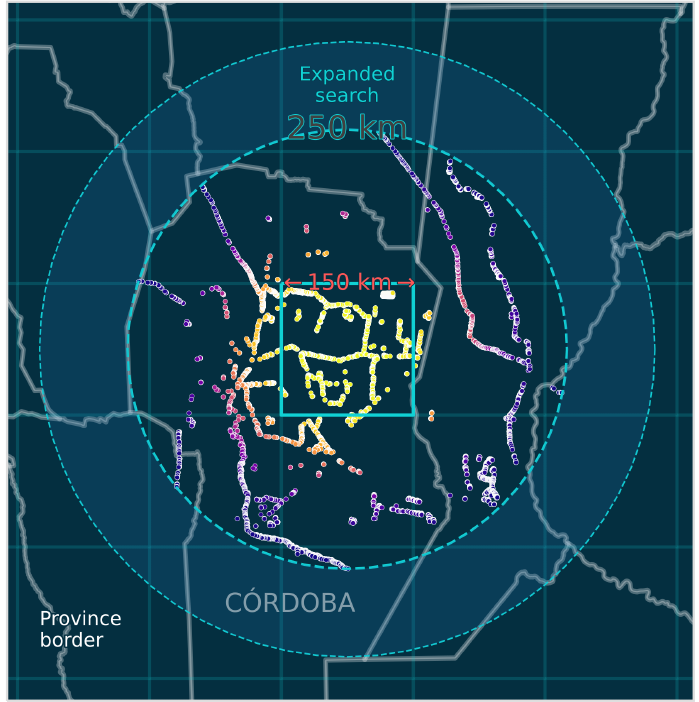
Figure 3. Diagram of spatial sampling approach. For a given grid cell (here, the center 150 km × 150 km grid cell), we locate all samples within a specified radius (250 km). If the sample pool for the grid cell is not satisfied by the initial radius, we expand the search distance up to 500 km, in 100 km intervals, until sufficient samples are